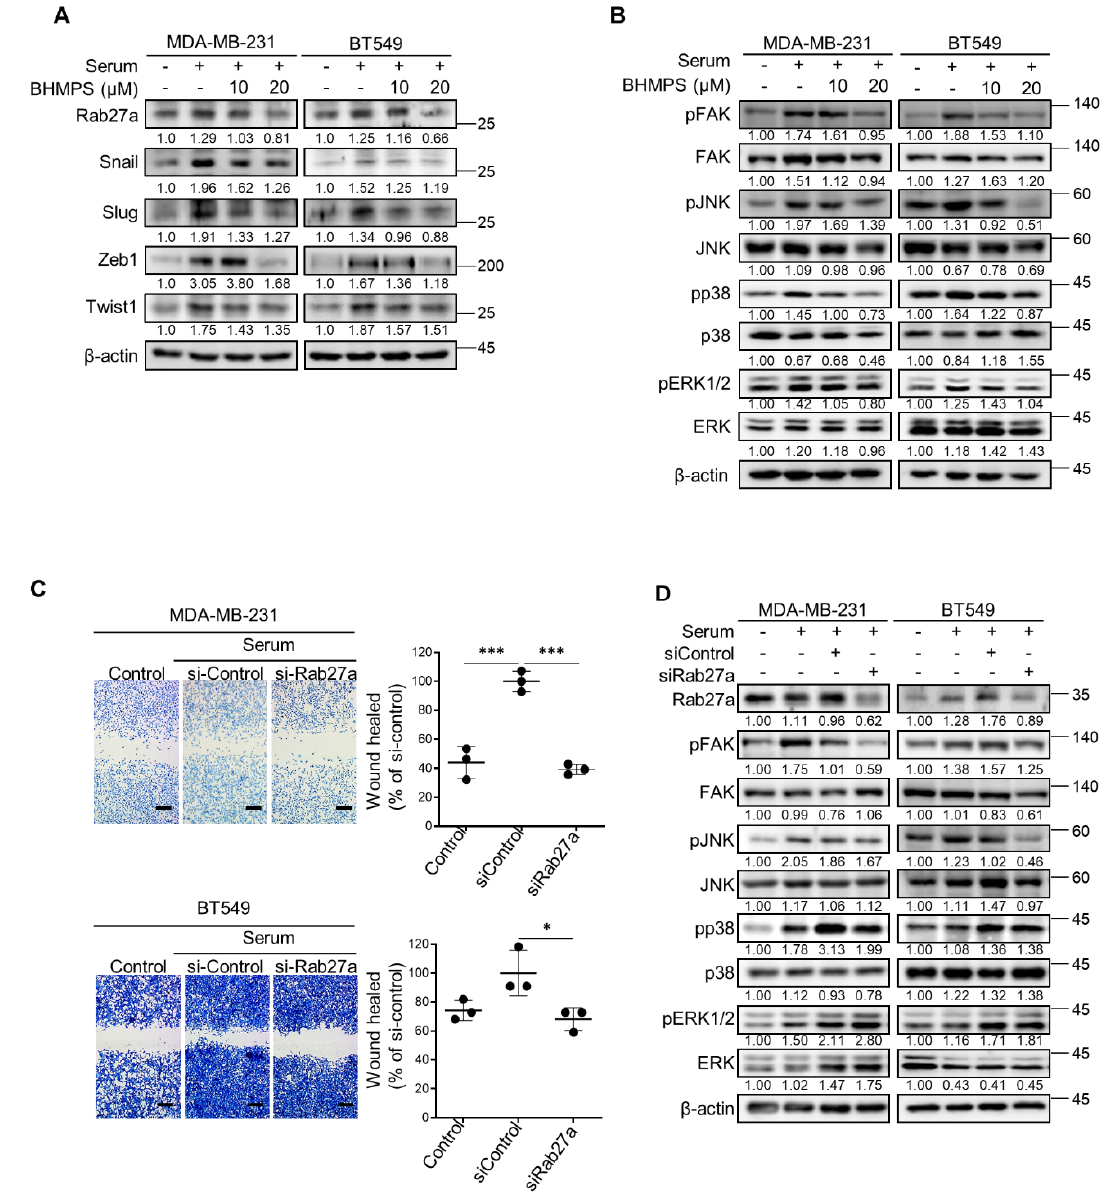
Figure 2. BHMPS inhibits EMT and FAK/MAPK activation. ( A ) Overnight serum-starved cells were stimulated with 10% FBS to induce EMT and co-treated with the indicated concentrations of BHMPS for 24 h. Levels of the specified proteins were compared by western blotting. ( B ) Under the same experimental conditions as ( A ), FAK and MAPK phosphorylation was evaluated by western